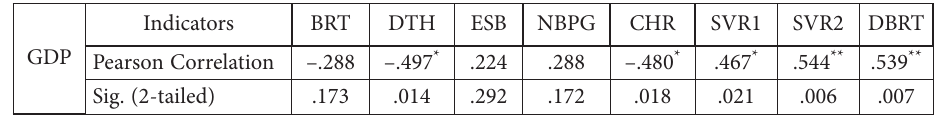
Table 9. The values of Pearson Correlation between GDP and factorial variables for Cluster B Indicators BRT DTH ESB NBPG CHR SVR1 SVR2 DBRT GDP Pearson Correlation –.288 –.497 * .224 .288 –.480 * .467 * .544 ** .539 ** Sig. (2-tailed) .173 .014 .292 .172 .018 .021 .006 .007